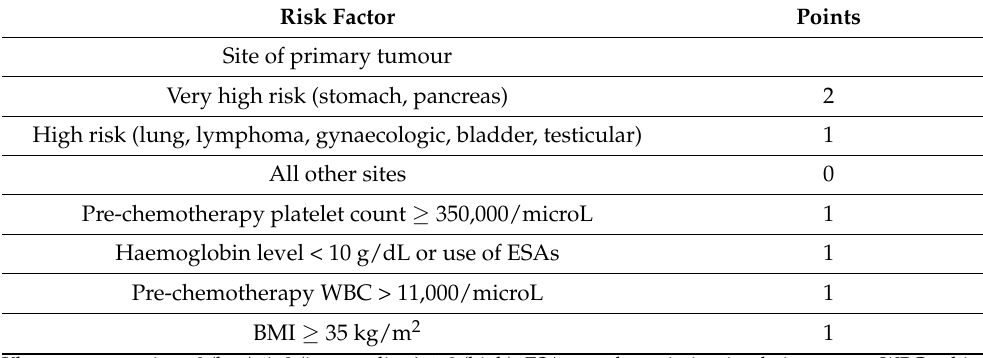
Table 2. Anticancer agents and thrombosis. Agent VTE ATE Cisplatin ++ − Platinum-based agents ++